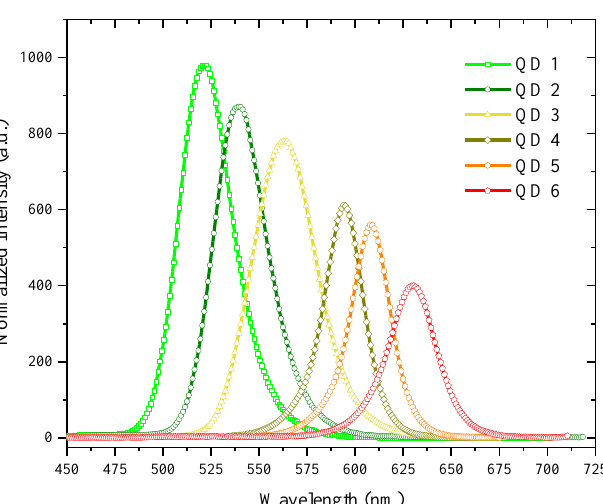
Figure 2. The photoluminescence (PL) for the different sized quantum dots at a concentration of 2 mg in 5 mL of THF.